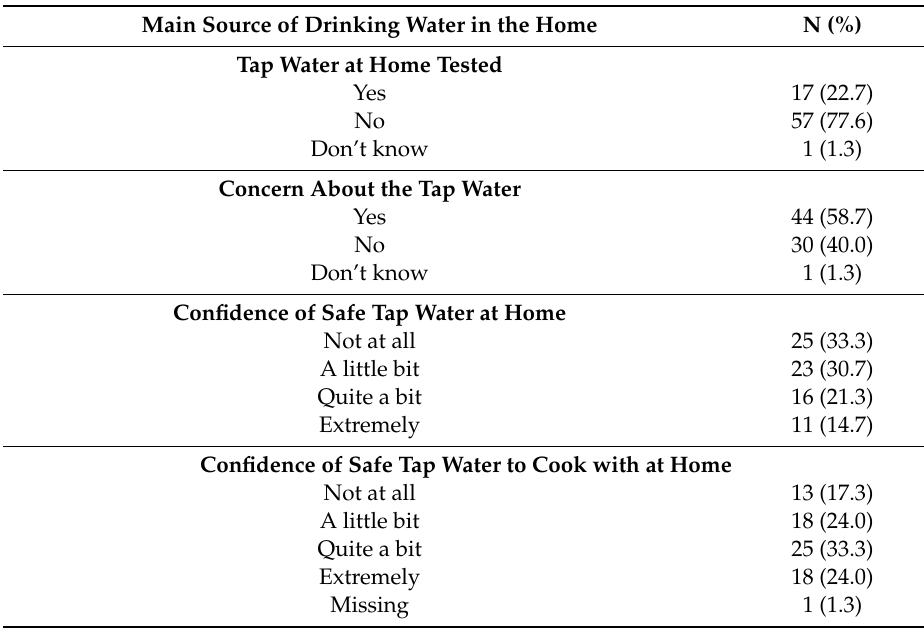
Main Source of Drinking Water in the